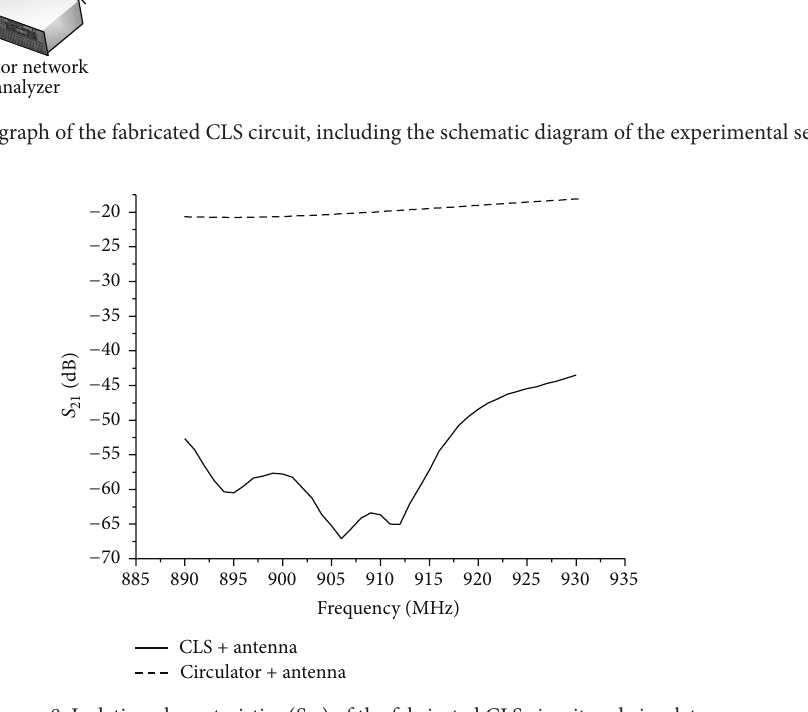
Figure 8: Isolation characteristics ( 𝑆 21 ) of the fabricated CLS circuit and